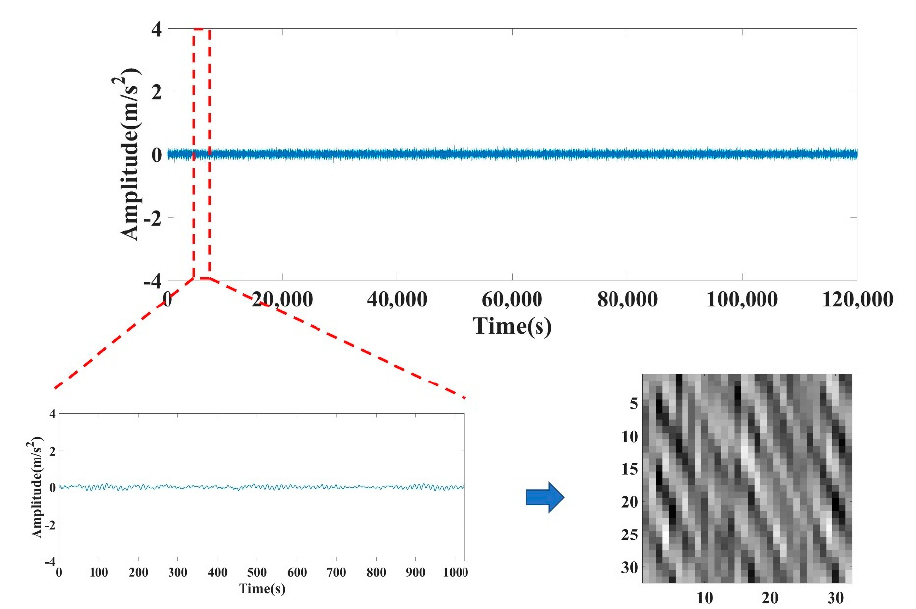
Figure 6. Data pre-processing procedure.